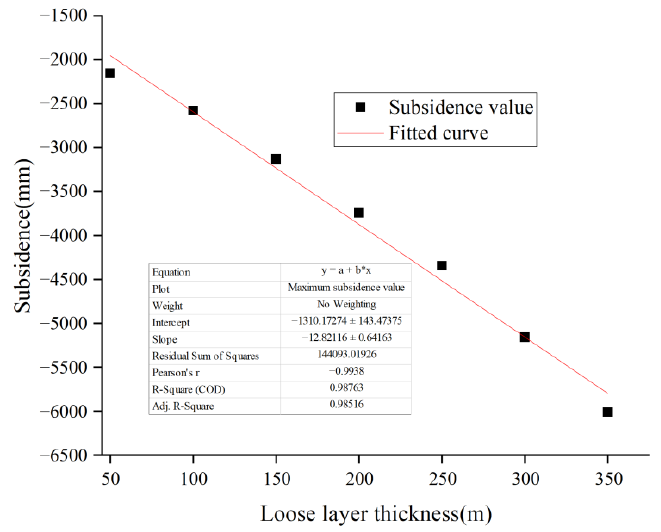
Figure 16. Relationship between surface subsidence value and thickness of loose layer.